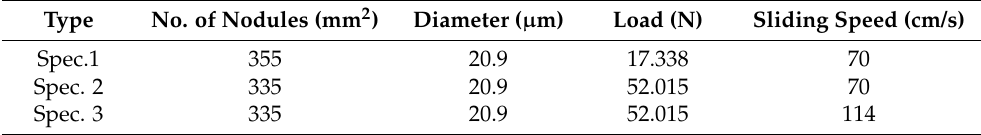
Table 3. Microstructure test characteristics.